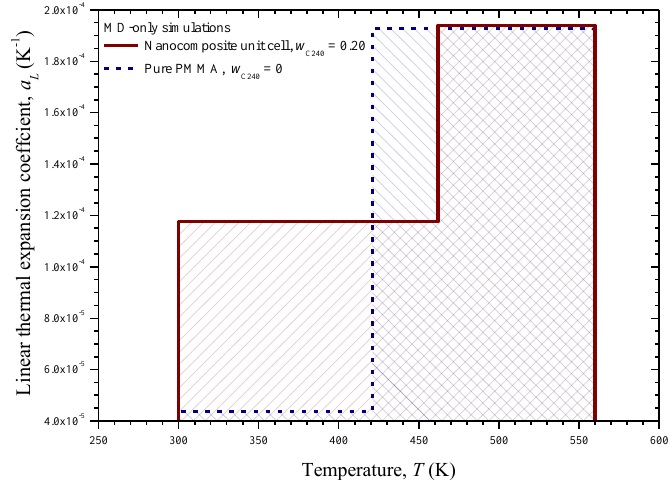
Figure 9. Linear thermal expansion coe ffi cient of the pure PMMA and the nanocomposite with w C240 = 0.2 unit cell with respect to the temperature.